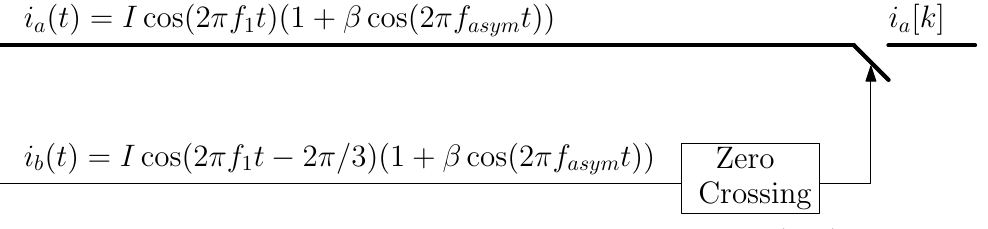
(cid:12) (cid:12) (cid:12) (cid:12) [ k ] (cid:12) i a (cid:12) in three-phase